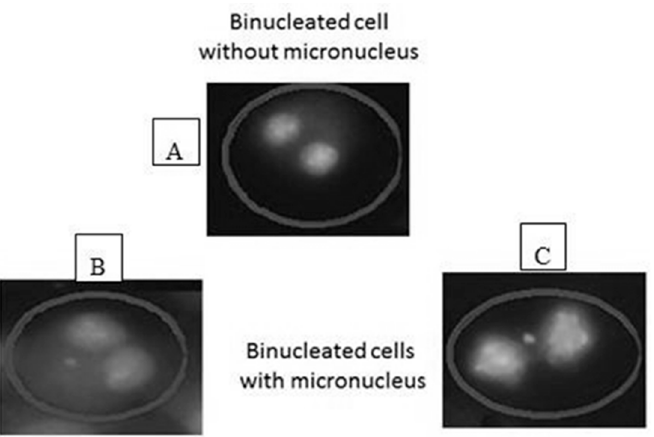
Figure 2. Scoring of binucleated cells: ( A ) a binucleated cell without micronucleus, ( B , C ) binucle- ated cells with micronucleus of different size. The cells were analyzed under ×40 magnification us- cells with micronucleus of different size. The cells were analyzed under × 40 magnification using ing fluorescent microscope fluorescent